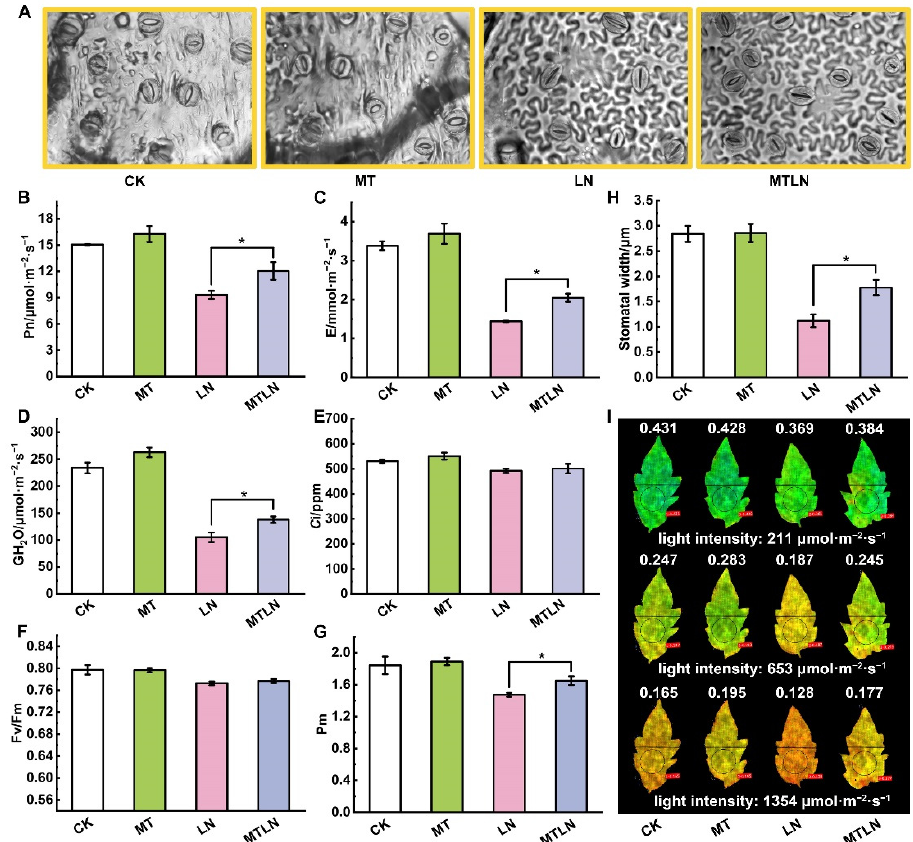
Figure 2. The effect of exogenous melatonin on photosynthetic gas exchange parameters and photosystem activity of tomato plants subjected to low night temperatures. Stomatal morphology ( A ); net photosynthetic rate (Pn) ( B ); transpiration rate (E) ( C ); stomatal conductance (GH 2 O) ( D ); intercellular carbon dioxide concentration (Ci) ( E ); maximum photochemical reaction efficiency of PSII (Fv/Fm) ( F ); maximum oxidation state of PSI (Pm) ( G ); stomatal width ( H ); chlorophyll fluorescence imaging of Y(II) ( I ). Data are presented as the mean ± standard deviation of four to six independent biological replicates. * p -value < 0.05; student’s t -test.